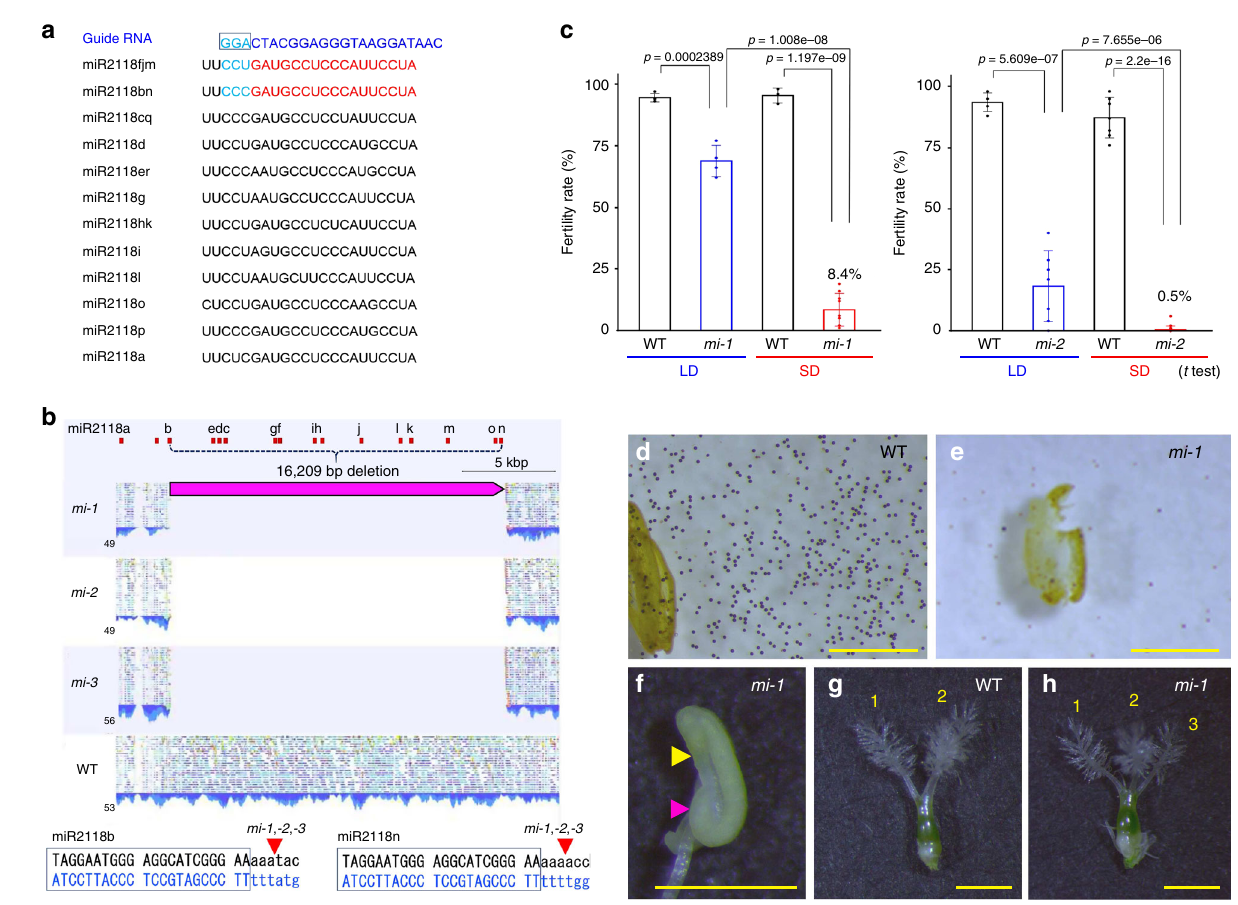
Fig. 1 miR2118 deletion mutants exhibit male and female sterility. a Sequence alignment of the 12 mature miR2118 family members in rice, and Cas9- guide RNA used for genome editing. The Cas9-guide RNA complementary sequence (blue) is mostly conserved in miR2118bn and miR2118fjm (red). The PAM sequence is shown in light blue in a black box. b Genome sequence read mapping in the miR2118 cluster region on rice chromosome 4 in the mi-1 , mi- 2 , and mi-3 lines. In all, 16,209 bp from miR2118b to miR2118n were deleted in the mir2118 lines. c Fertility of Nipponbare (WT) and two mir2118 mutants grown under long-day (LD) and short-day (SD) conditions. Data are mean ± SD of more than three biological replicates. Student ’ s t test. d , e Mature pollens stained with iodine-potassium iodide of the WT and mir2118 line. f An anther of mi-1 . Yellow arrowhead indicates the shorter inner locule. Magenta arrowhead indicates the curled outer locule. g , h . Pistils of the WT and mi-1 line. An additional stigma was observed in the mir2118 line. Yellow bars indicate 1